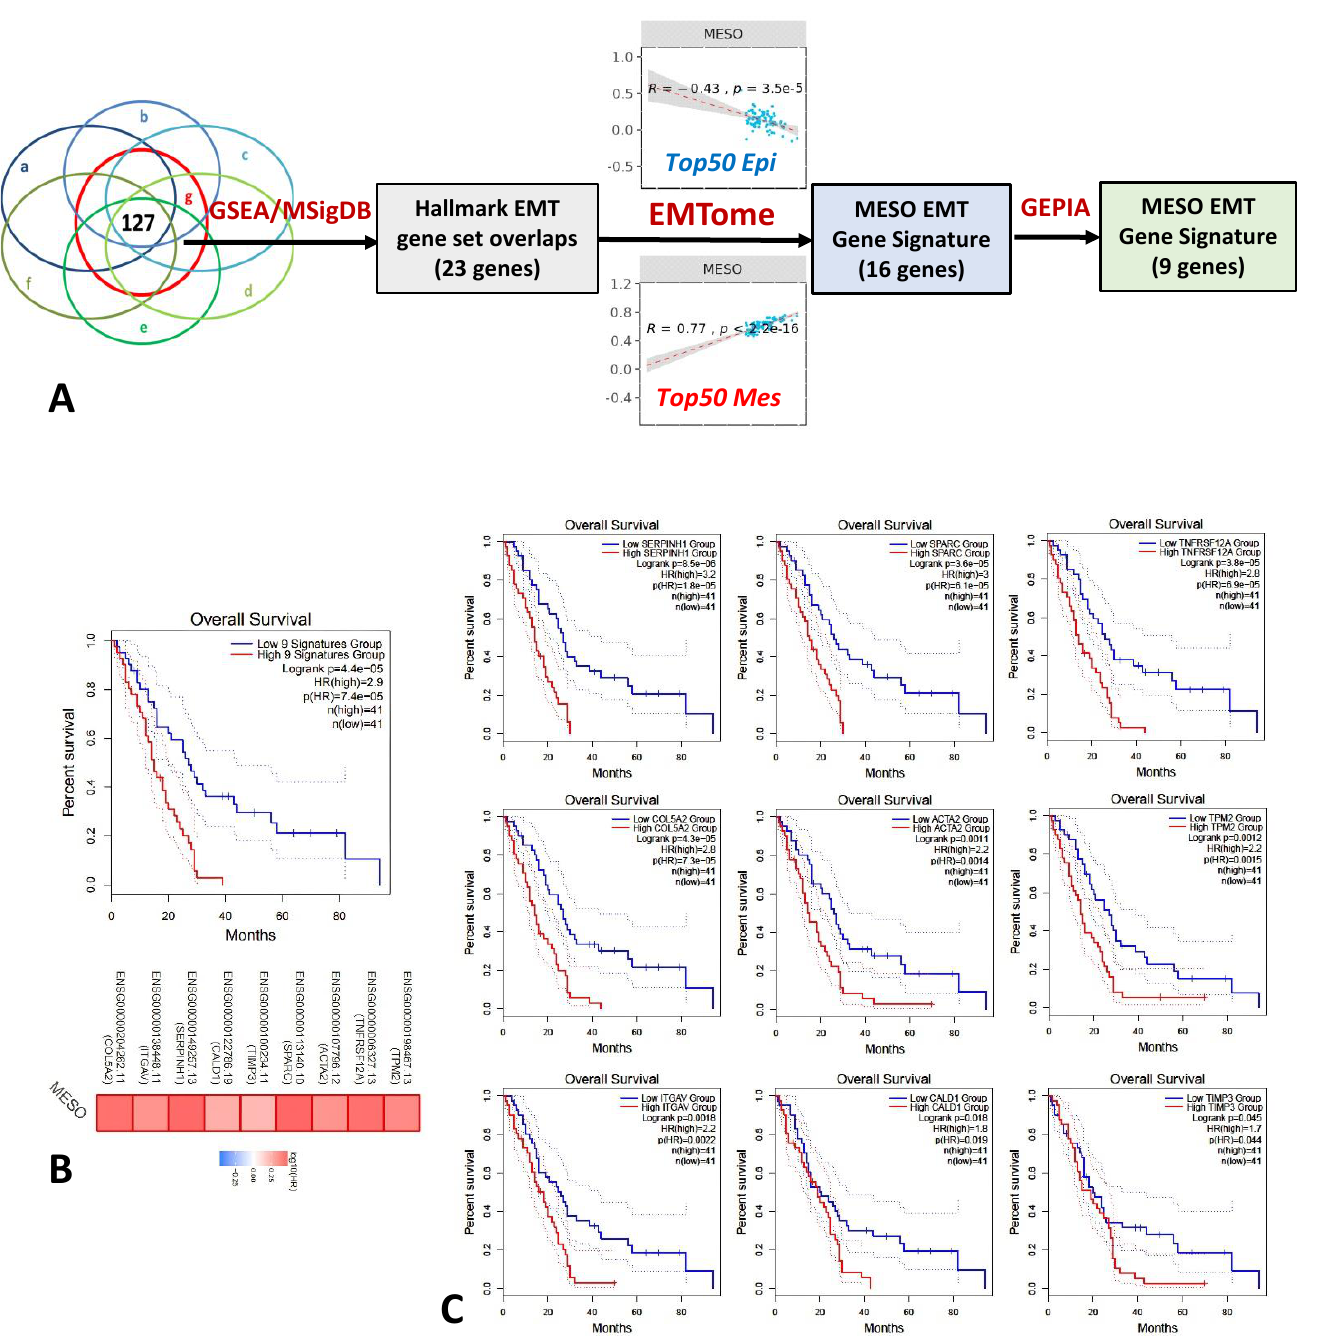
Figure 1. Mesothelioma EMT gene signature. ( A ) Twenty-three genes were identified by overlapping upregulated genes after tumor cell injection in mice and the Hallmark EMT gene set using the gene set enrichment analysis (GSEA) MSigDB database 16 , 16 genes then positively correlated with the mesenchymal phenotype and negatively correlated with the epithelial phenotype in the EMTome, and finally, 9 genes were associated with survival differences using GEPIA in the MESO TCGA